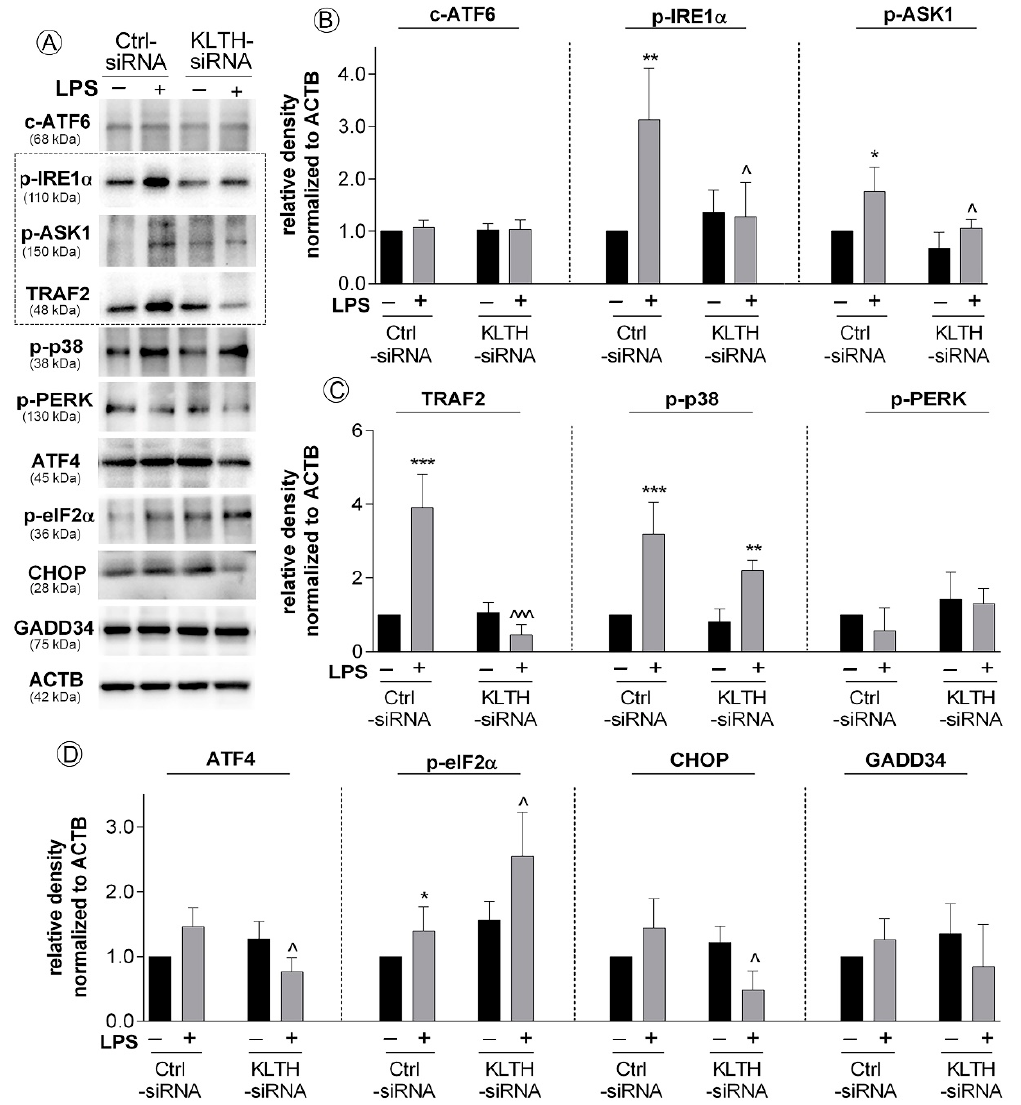
Figure 6. Klotho-silencing promotes activation of ER stress response but not autophagy. The cells were transfected, treated for 48 h with LPS and then, the following parameters: ( A – D ) expression of proteins involved in ER stress response was controlled. Bars indicate SD, n = 3, *** / ˆˆˆ p < 0.001, ** p < 0.01, * / ˆ p < 0.05, no indication / no statistical significance (one-way ANOVA and Dunnett’s a posteriori test). (*) indicate comparison between LPS-non-treated and treated Ctrl-siRNA or KLTH-siRNA cells, (ˆ) indicate comparison between LPS-non treated Ctrl-siRNA and KLTH-siRNA cells or LPS-treated Ctrl-siRNA and KLTH-siRNA cells.